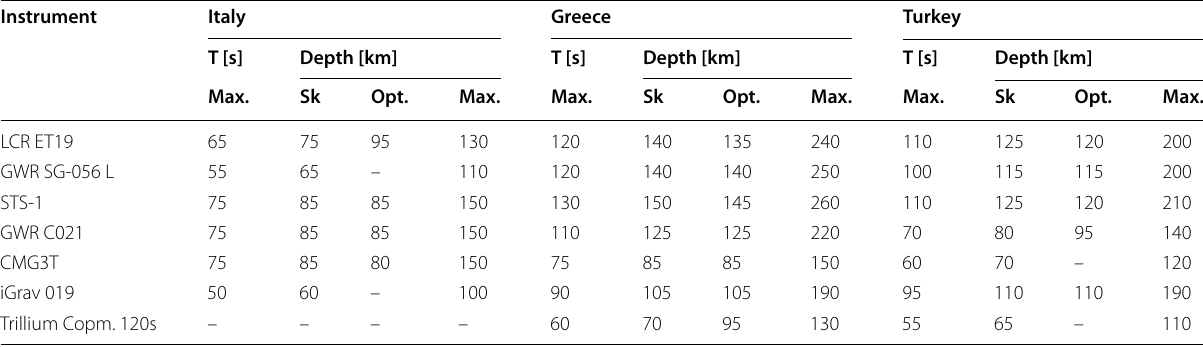
Table 2 List of instruments for all regions investigated (Italy, Greece, Western Turkey) with maximum period (T max), sensitivity kernels (sk) depth, optimum (opt) and maximum (max) resolution depths